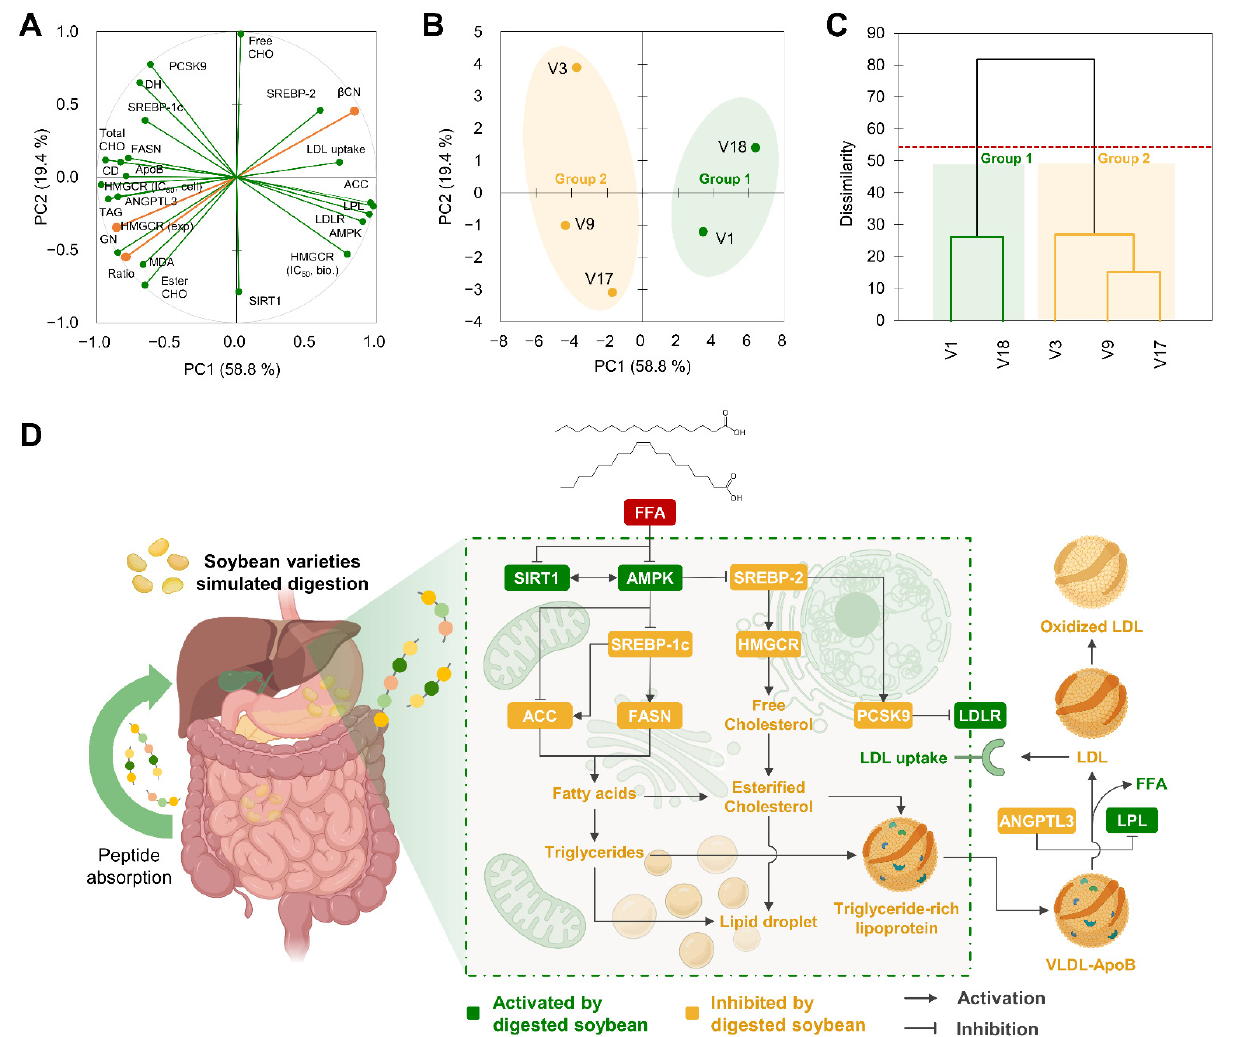
Figure 10. Principal component (PC) analysis (loadings in ( A ) and PC scores in ( B )), including the composition of soybean varieties, digests, HMGCR inhibitory properties, and hypocholesterolemic effects in free fatty-acid-stimulated liver cells. Dendrogram of the hierarchical cluster analysis classifying samples ( C ). Illustrative diagram summarizing the main signaling pathways modulated by the different soybean varieties digested under gastrointestinal conditions on hepatic lipid and cholesterol-LDL metabolism and oxidation ( D ).